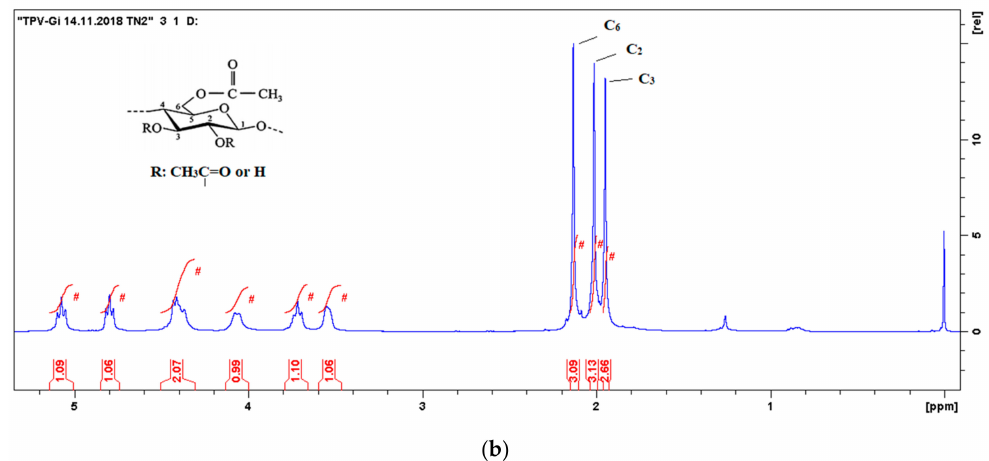
Figure 3. 1 H-NMR spectra for ( a ) CA-1 (DS = 2.67) and ( b ) CA-2 (DS = 2.81).